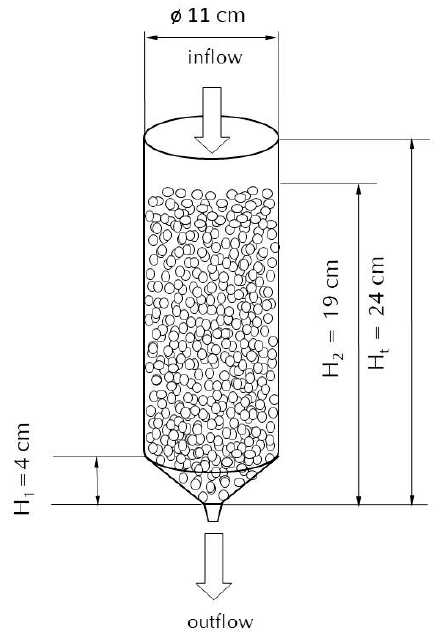
Figure 1. Biofilter with LECA (Light Expanded Clay Aggregates) filling.